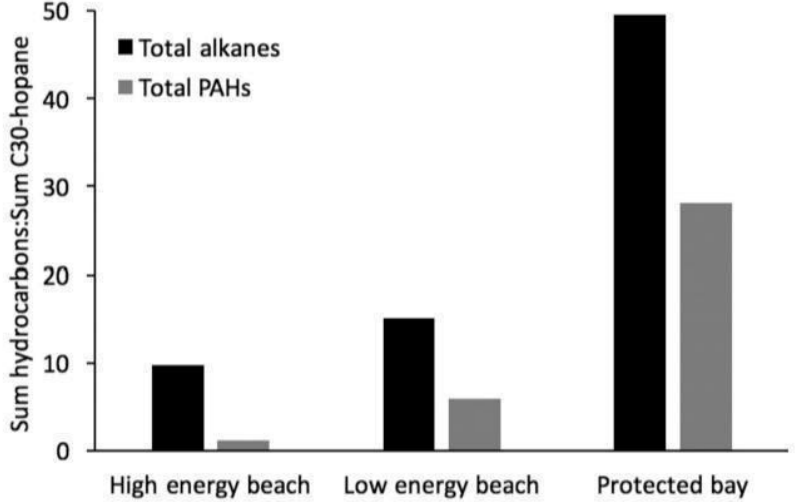
Figure 12. The sum of n -alkanes C 10-37 and the 16 EPA listed priority PAHs, normalized to internal recalcitrant biomarker C 30 -hopane, are presented for three samples collected between 678 and 694 days following the Deepwater Horizon oil spill. For both hydrocarbon categories, content is highest in a protected bay sediment sample and lowest in a high energy beach sediment sample, illustrating the effect of shoreline energy on hydrocarbon weathering. Adapted from Bacosa et al. [5].